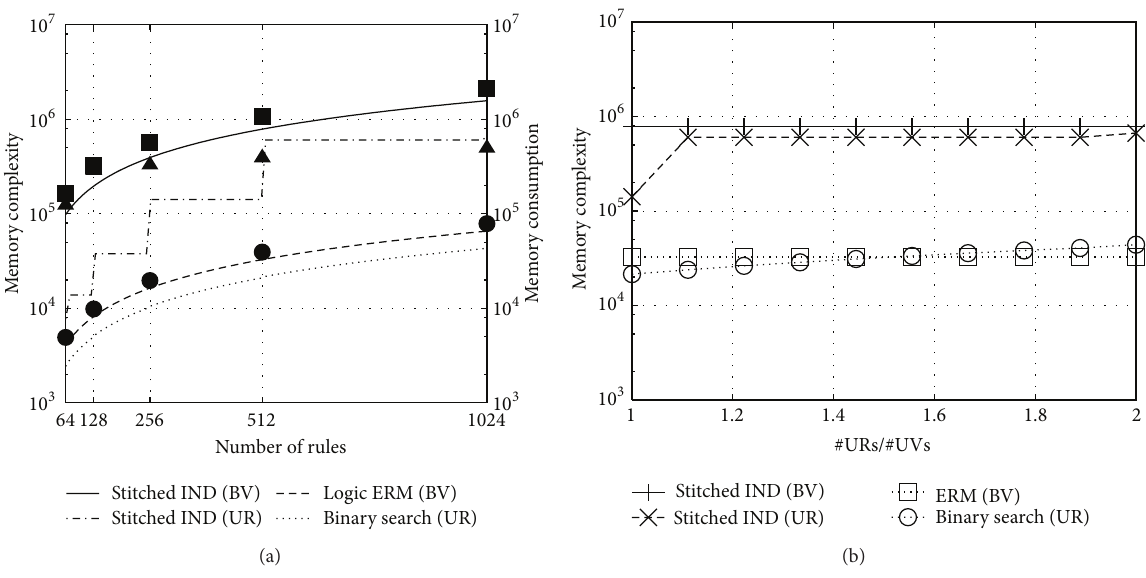
Figure 20: Memory complexity: (a) | UR | = | UV | = 𝑁 , 64 ≤ 𝑁 ≤ 1024 and (b) | UV | = 𝑁 = 512 , | UV | ≤ | UR | ≤ 2 ⋅ | UV | .